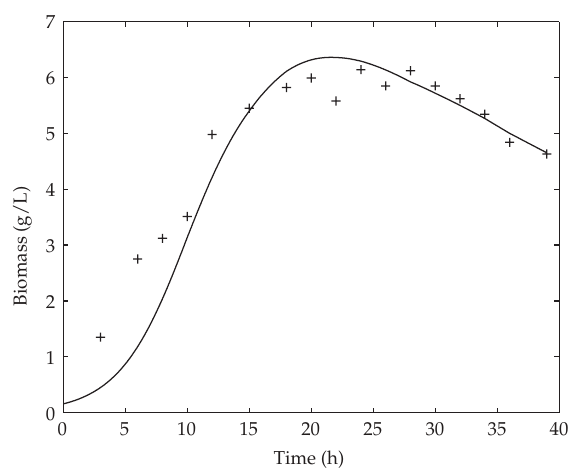
Figure 2: Comparison of biomass concentration between experimental data and computational